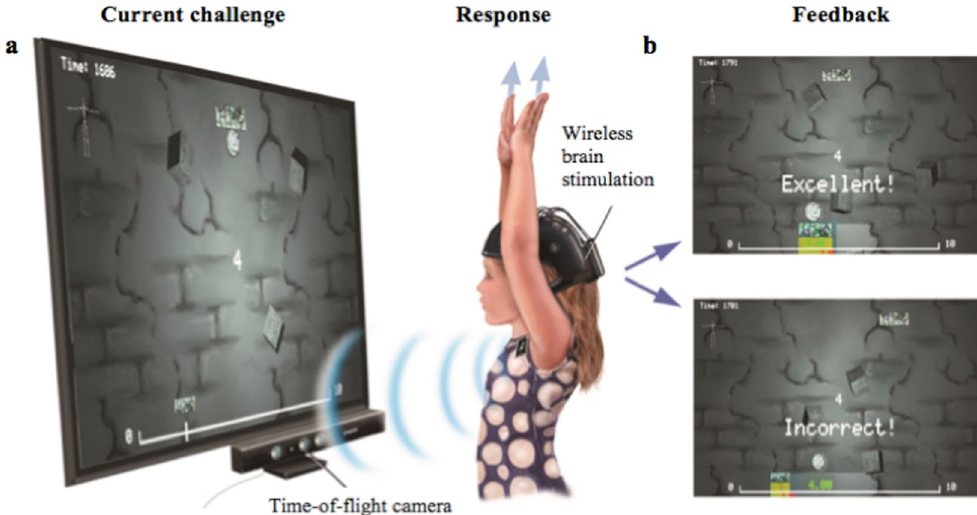
Figure 1. Transcranial random noise stimulation coupled with cognitive training to improve learning of children with mathematical learning disabilities at school ( a ) Illustration of a child moving from side-to-side to map a number on a number line while receiving transcranial random noise stimulation from a wireless brain stimulator. Response was registered for each trial when both hands were raised. Body movements were detected by a time-of-flight camera, Kinect TM . ( b ) Examples of feedback on correct and incorrect responses. The